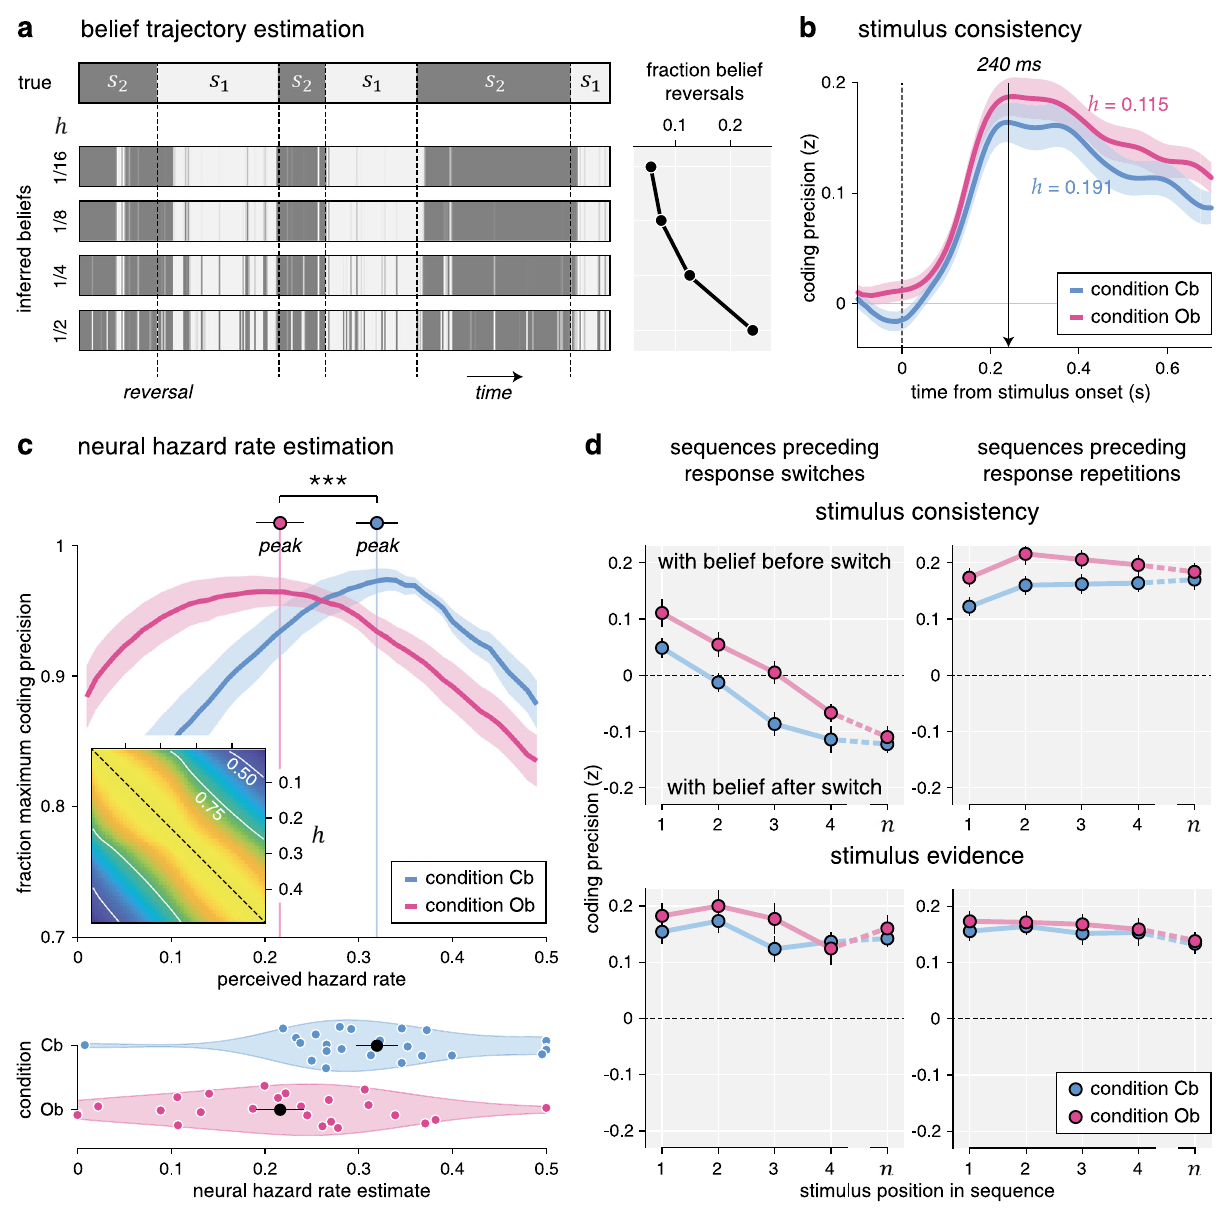
Fig. 6 Belief trajectory estimation and analysis. a Estimation of belief trajectory from behavior and perceived hazard rate. Left: each horizontal strip indicates the evolution of the hidden state s over the course of an example block. The upper strip indicates the true hidden state (with vertical dotted lines indicating reversals), whereas the lower strips indicate inferred beliefs in the current hidden state for increasing perceived hazard rates, from 1/16 (top) to 1/2 (bottom). Belief trajectories at trial t are conditioned on observed responses up to trial t using particle fi ltering. Right: fraction of mid-sequence belief reversals associated with each belief trajectory, growing with the perceived hazard rate. b Neural coding of consistency with the ongoing belief, computed using the estimated belief trajectory based on the best- fi tting perceived hazard rate in each condition (lower in the outcome-based condition). Lines and shaded error bars indicate means ± SEM. Consistency is coded equally precisely in the two conditions. c Estimation of neural hazard rate. Relative coding precision of consistency ( y axis, expressed as the fraction of the maximum per participant and condition) as a function of perceived hazard rate ( x axis). The neural hazard rate is de fi ned as the perceived hazard rate, which maximizes coding precision (dots and error bars indicate its mean ± SEM). Lines and shaded error bars indicate means ± SEM. Inset: correlation matrix ( r 2 ) for consistency based on the full range of possible hazard rates. Estimation of the neural hazard rate relies on differences between consistency variables. d Neural coding trajectories preceding response reversals (left column) and repetitions (right column), for consistency with the belief at the beginning of the current sequence (top row) and the strength of stimulus evidence (bottom row). Sequences leading to response reversals are associated with switches in the neural coding of consistency, not stimulus evidence, which are delayed in the outcome-based condition. Dots and error bars indicate means ± SEM ( n = 24 participants). Three stars indicate a signi fi cant effect at p < 0.001 (paired two-sided t -test, d.f. = 23, no correction for multiple comparisons). Source data are provided as a Source Data fi